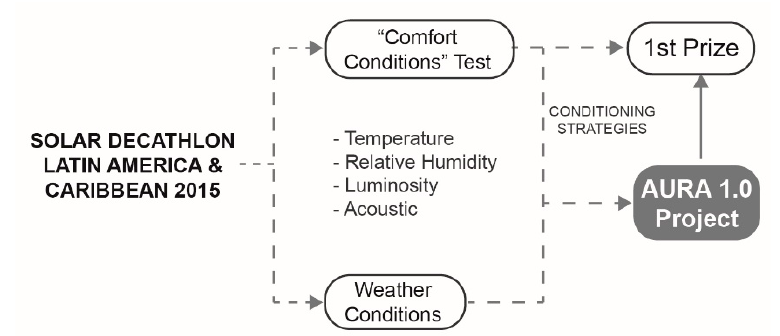
Figure 2. Diagram of the used methodology.